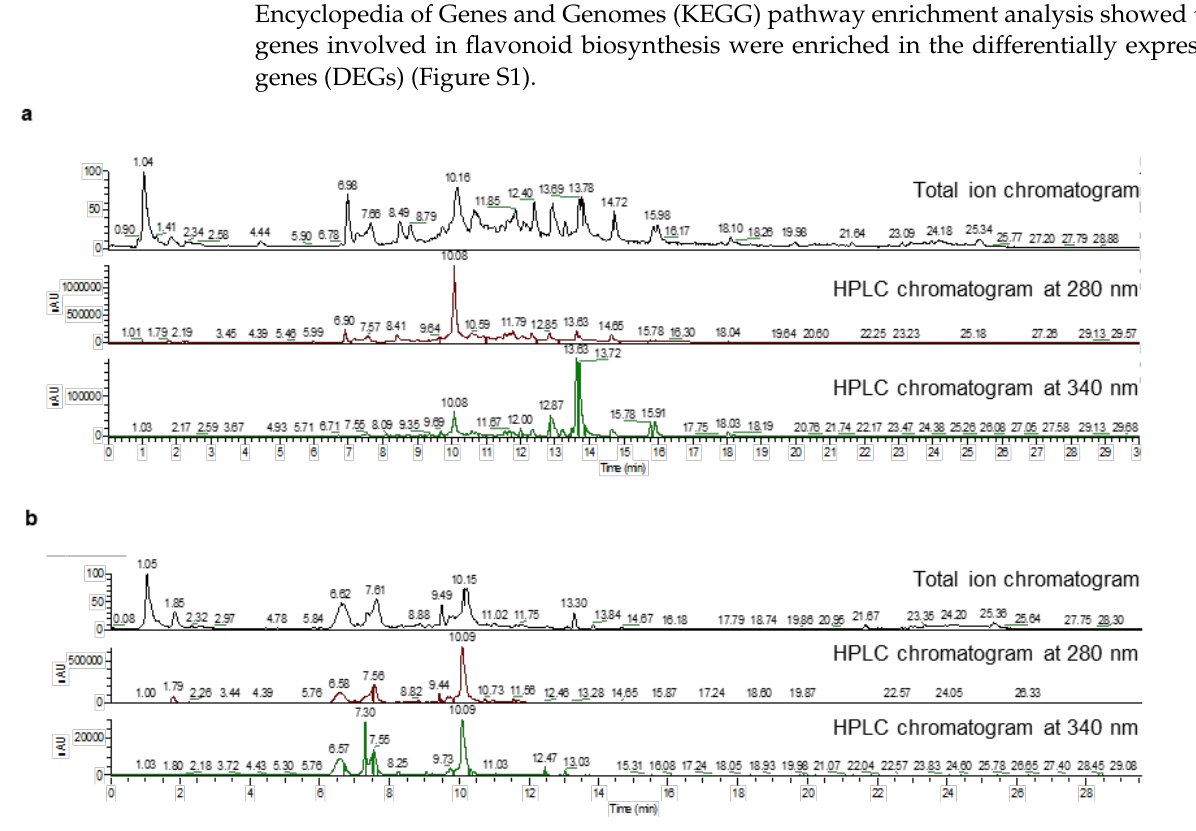
Figure 1. Metabolite analysis of pomegranate anthers and petals. ( a ) Chromatograms of liquid chromatography high-resolution electrospray ionization mass spectrometry (LC-HR-ESI-MS) for metabolites extracted from pomegranate anthers. ( b ) Chromatograms of LC-HR-ESI-MS for metabolites extracted from pomegranate petals.